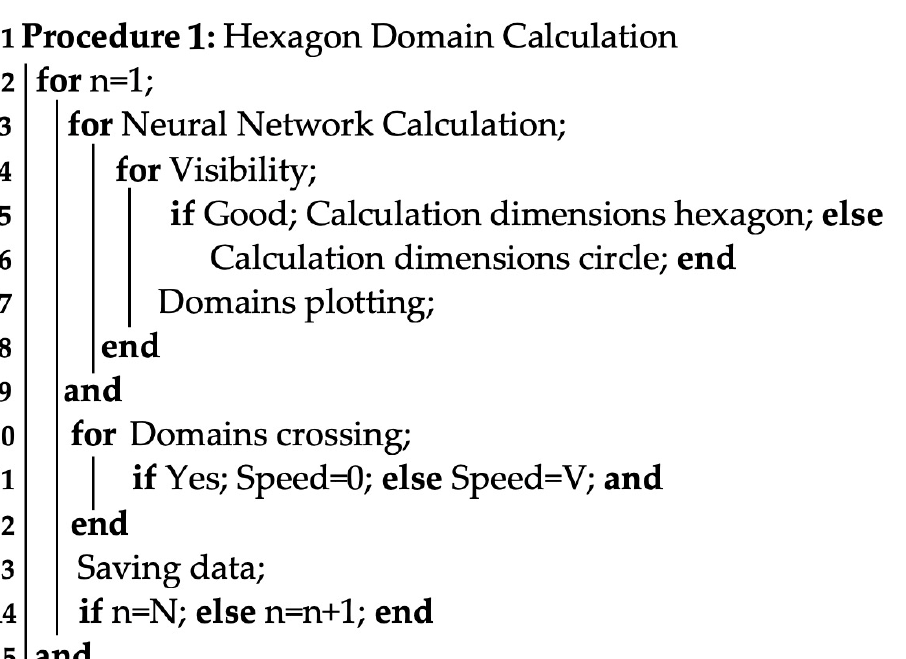
Figure 6. Flow chart of procedure 1 a computer program representing the computation of a hexagonal domain.